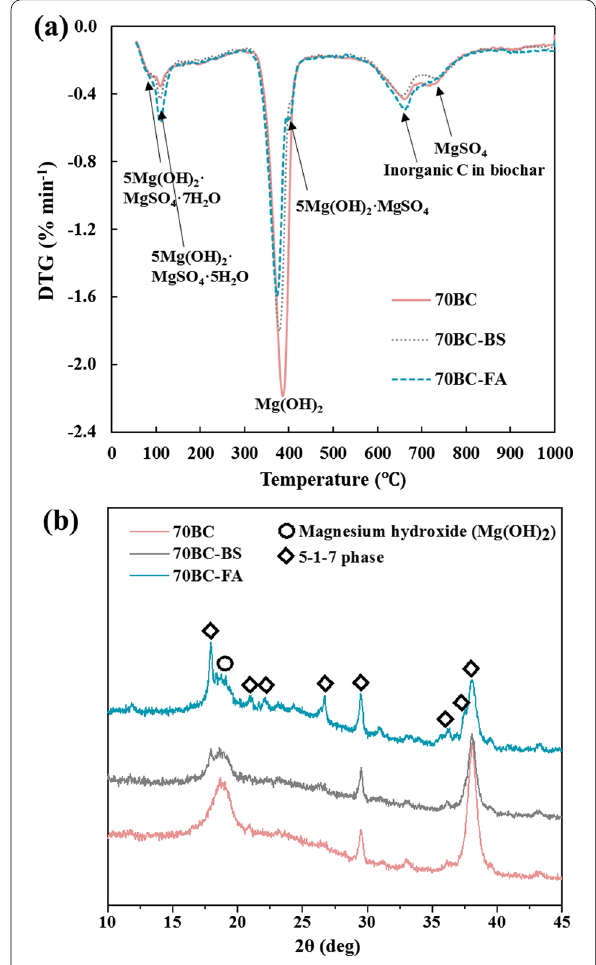
Fig. 3 DTG curves ( a ) and XRD patterns ( b ) of the MOSC biochar particleboards